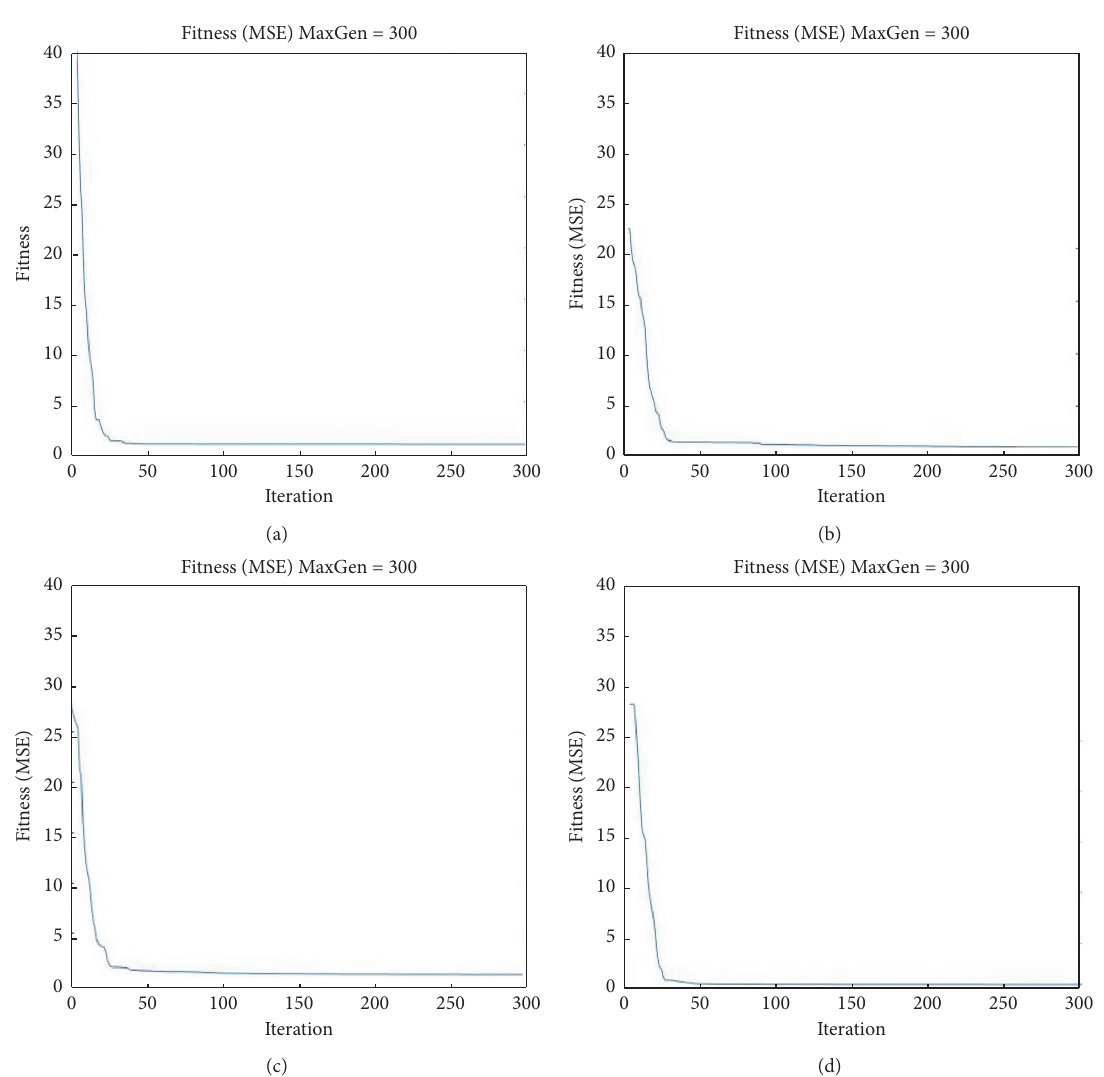
Figure 6: NN performance (MSE) adopting different PSO optimizations. (a) PSO without inertial weight; (b) PSO with w and (d) PSO with w 3